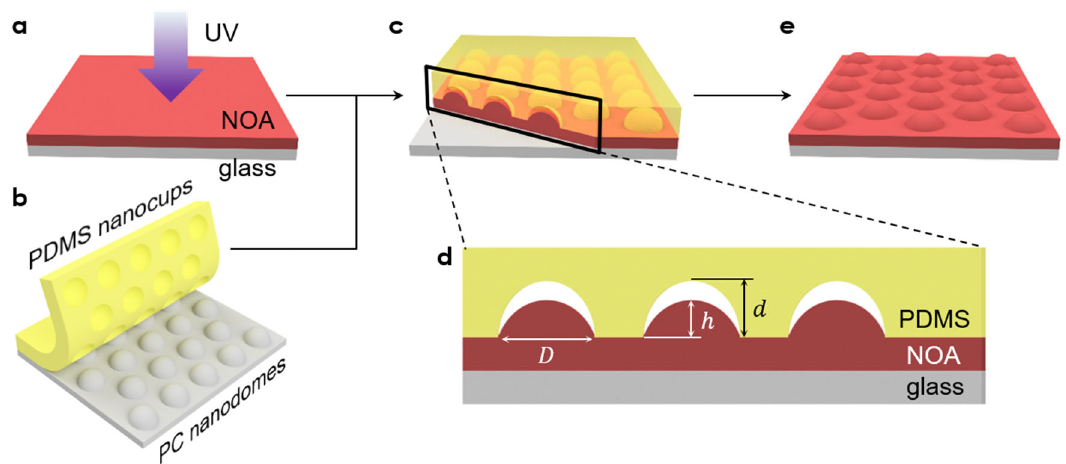
Figure 1. A schematic description of the curvature ‐ adjustable polymer nanolens fabrication process. ( a ) Spin ‐ coating of a photopolymer (NOA73) film and its partial UV pre ‐ curing. ( b ) Replica molding of PDMS nanocups from PC nanodomes. ( c ) Forming intimate contact between the PDMS nanocup array with the partially cured NOA73 film to induce the nanoscale rise of NOA73 into the nanocup cavities. ( d ) A cross ‐ sectional snapshot showing underfilled PDMS nanocups. ( e ) Post ‐ curing and releasing of the PDMS mold reveal the curvature ‐ adjusted nanolens array.